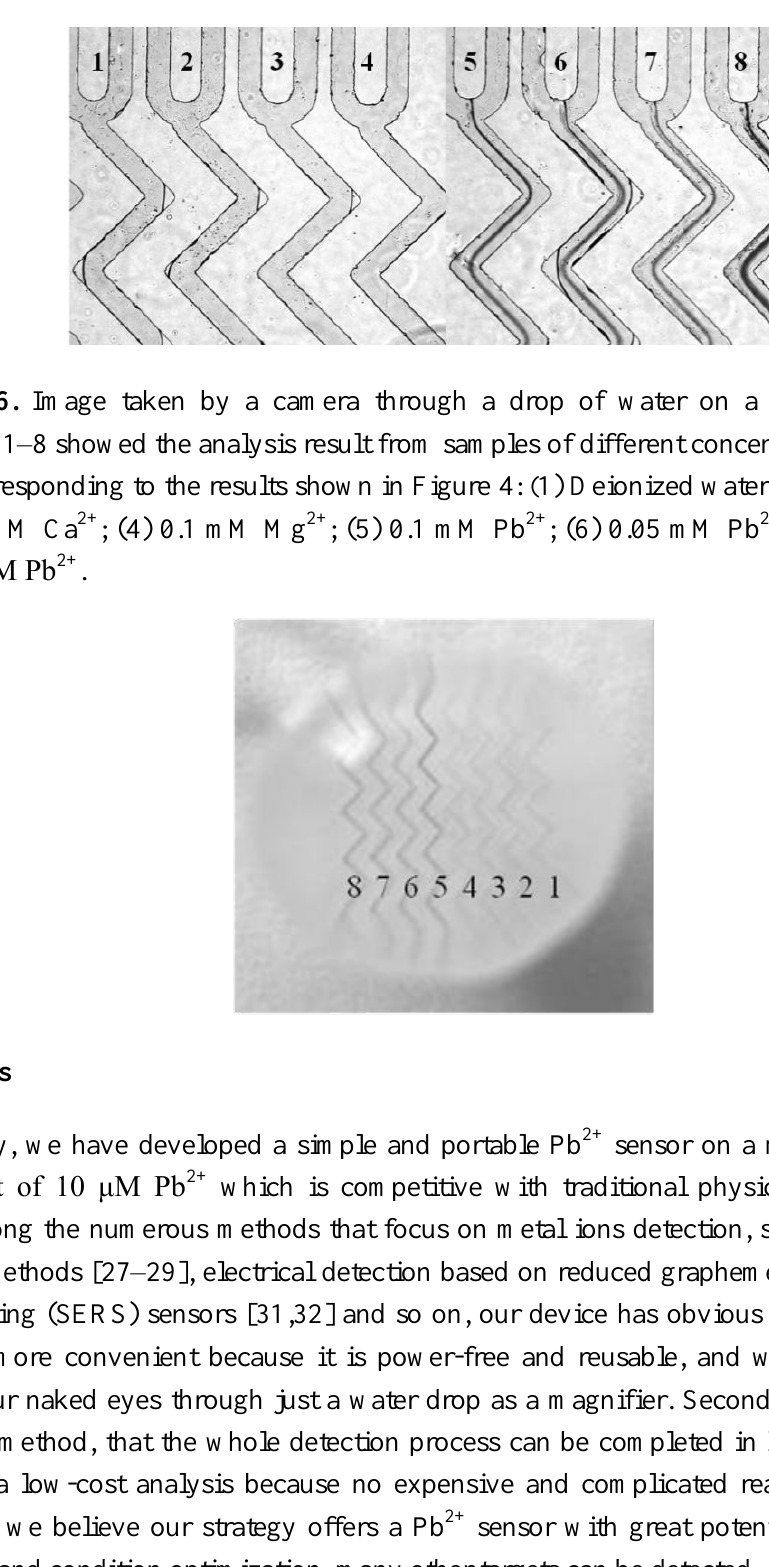
Figure 5. Microscope images of the lines in multi-microchannels microfluidic chip in the presence of different ion solutions. (1) 100 μM Mg 2+ ; (2) 100 μM Ca 2+ ; (3) 100 μM NaCl;